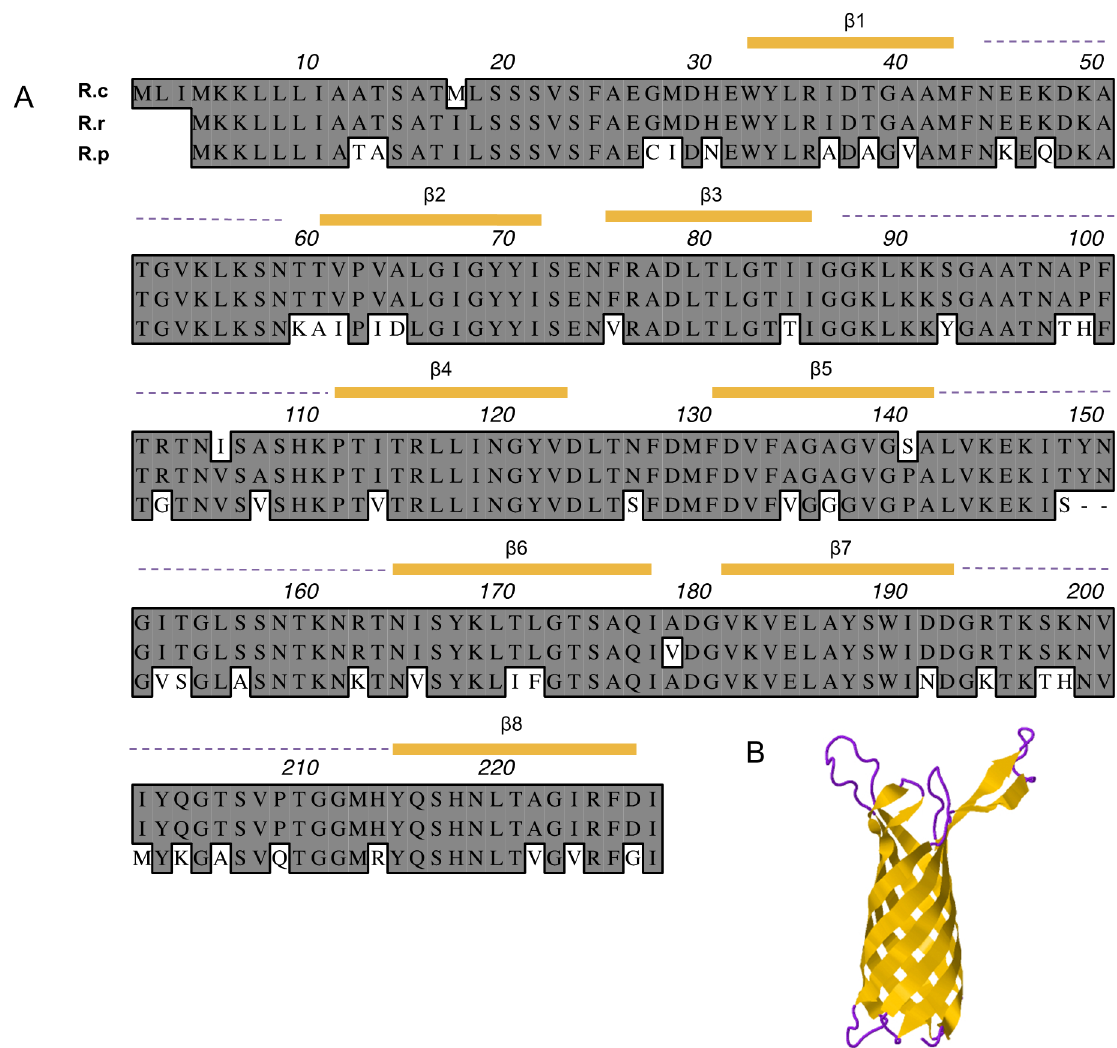
Fig 1. Adr2 is highly conservedamong pathogenic rickettsial species. (A) ClustalW alignment of Adr2 homologs from rickettsial species in both Spotted Fever Group ( R . conorii , R . rickettsii ) and Typhus Group ( R . prowazekii ). Predicted β -sheets and surface exposedloops are indicatedin yellow and purpledashedlines, respectively. (B) Phyre2 predictedstructure of R . conorii Adr2 demonstrates of 8 transmembrane β -sheetsconfiguredin a “barrel”-like structure with possiblesurface exposed